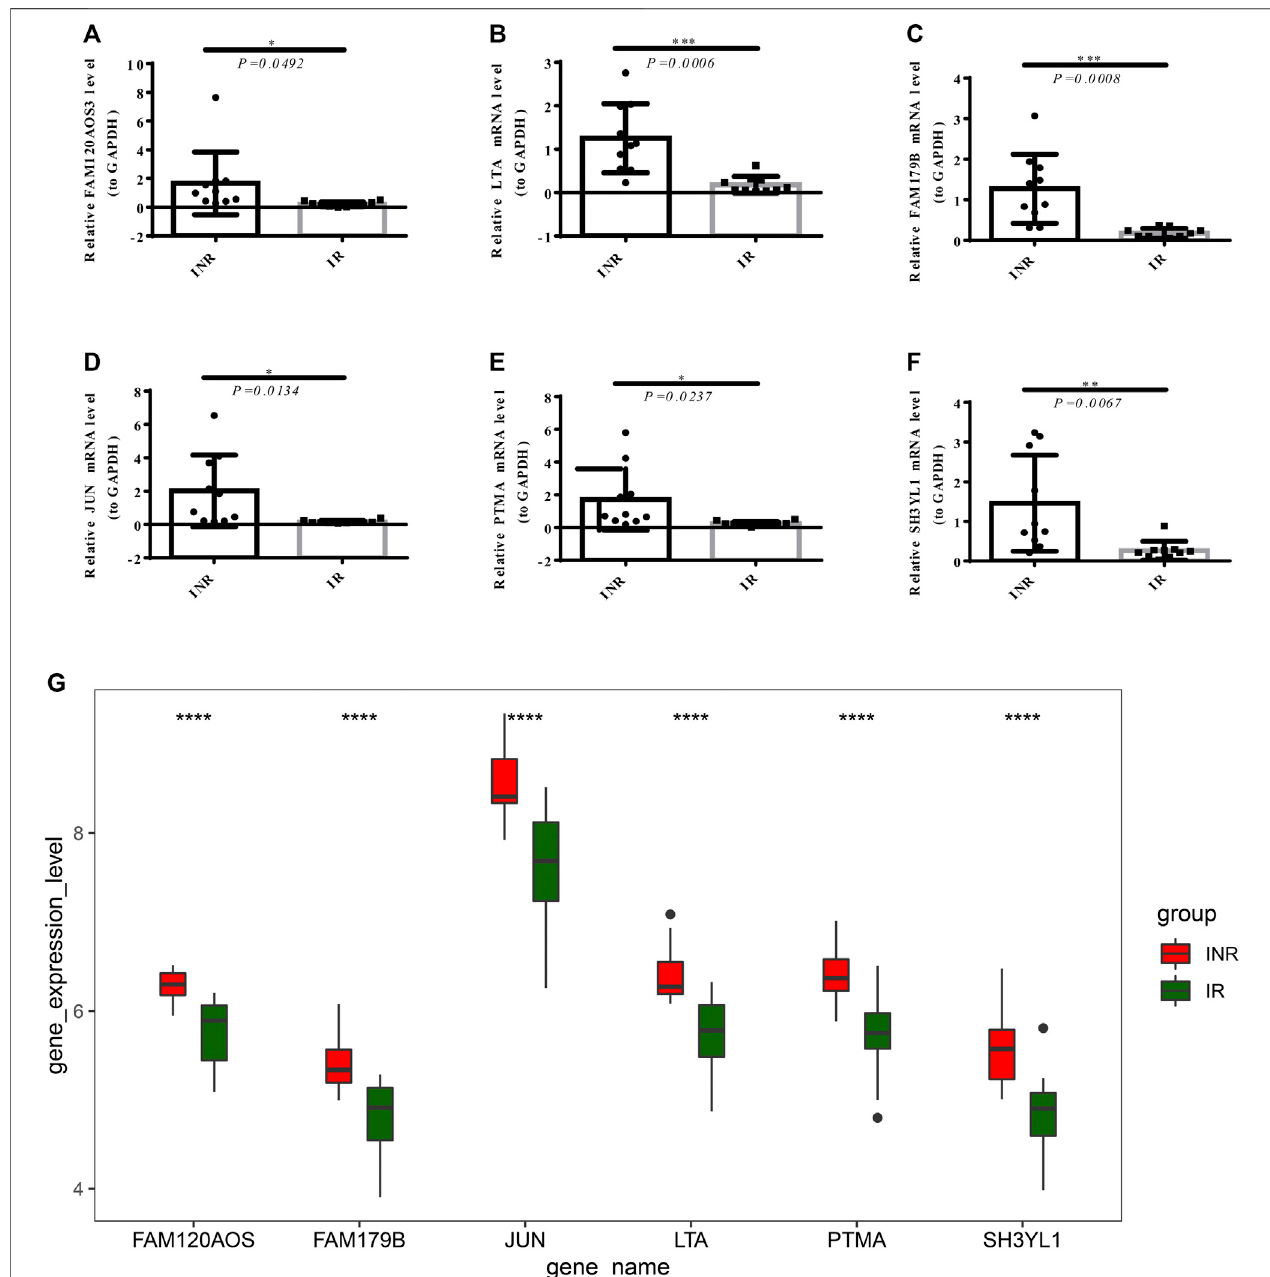
FIGURE7 | The mRNA expression ofdiagnosticmarkers inclinical 10 INRs and 10 IRs samples were detected by RT-PCR. The expression ofFAM120AOS, LTA, FAM179B, JUN, PTMA, and SH3YL1 (A – F) between the INRs and IRs samples (* p < 0.05, ** p < 0.01, *** p < 0.001). (G) The expression of the diagnostic markers in merged GEO series (**** p <